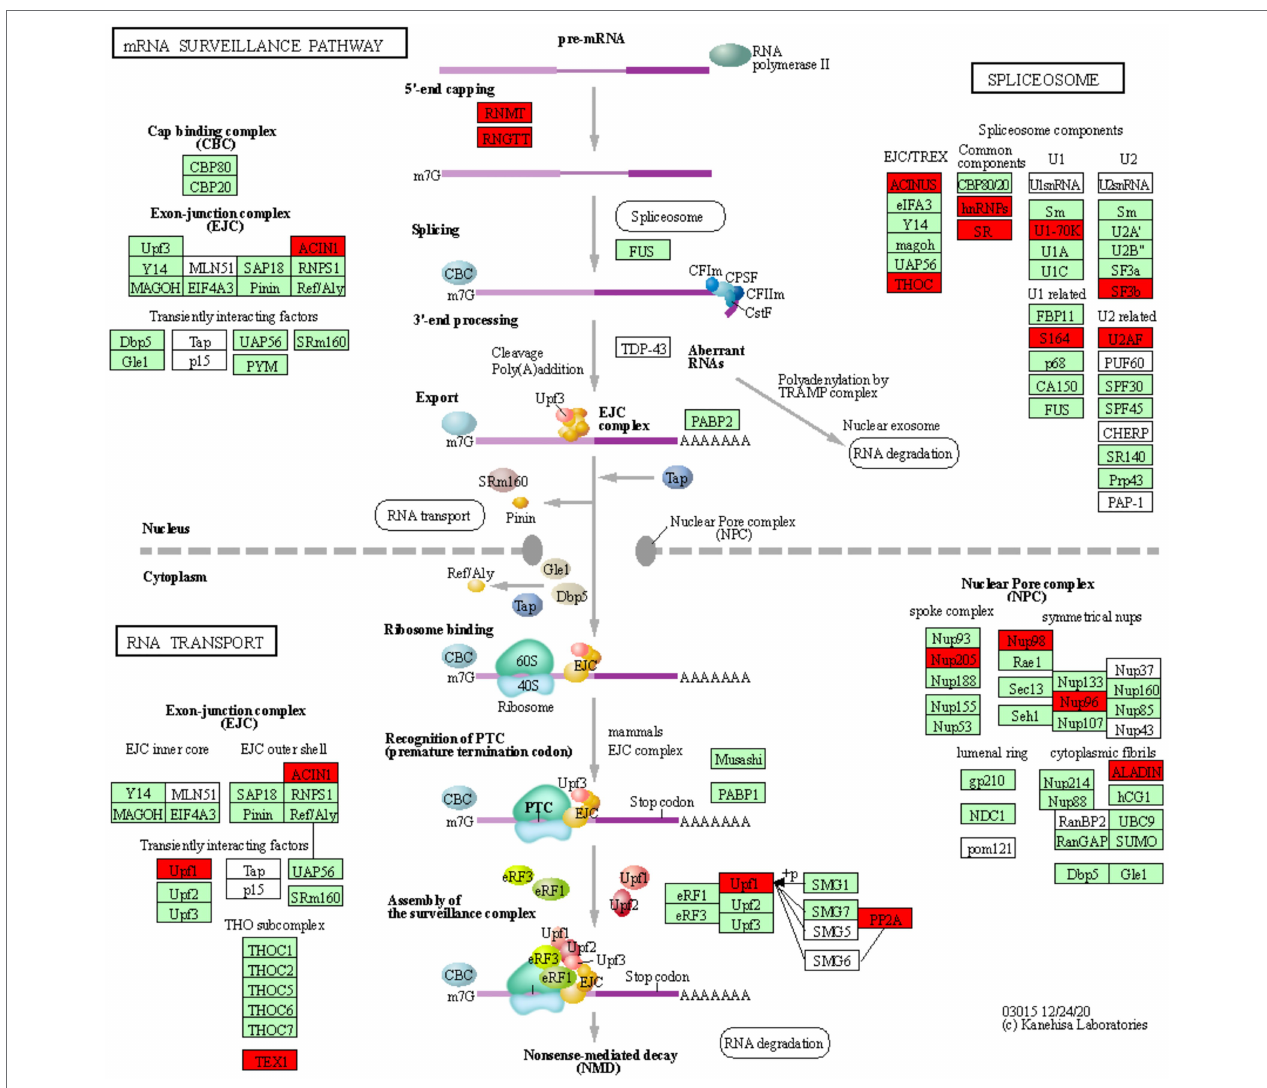
FIGURE 3 | mRNA surveillance KEGG pathway. KOBAS was used to illustrate the enrichment of genes that are downregulated in Thatcher upon leaf rust infection. Osa03015 (enrichment corrected p -value 4.36E-02) includes two additional enriched “sub-pathways”: spliceosome (osa03040, corrected p -value 2.77E-02) and RNA transport (osa03013, corrected p -value 2.22E-03). In total, these three pathways contain 29 unique downregulated genes. Red boxes: genes that were downregulated; light green boxes: Oryza sativa genes that have been previously identified; white boxes: genes that belong to the KEGG pathway but have no currently identified O. sativa